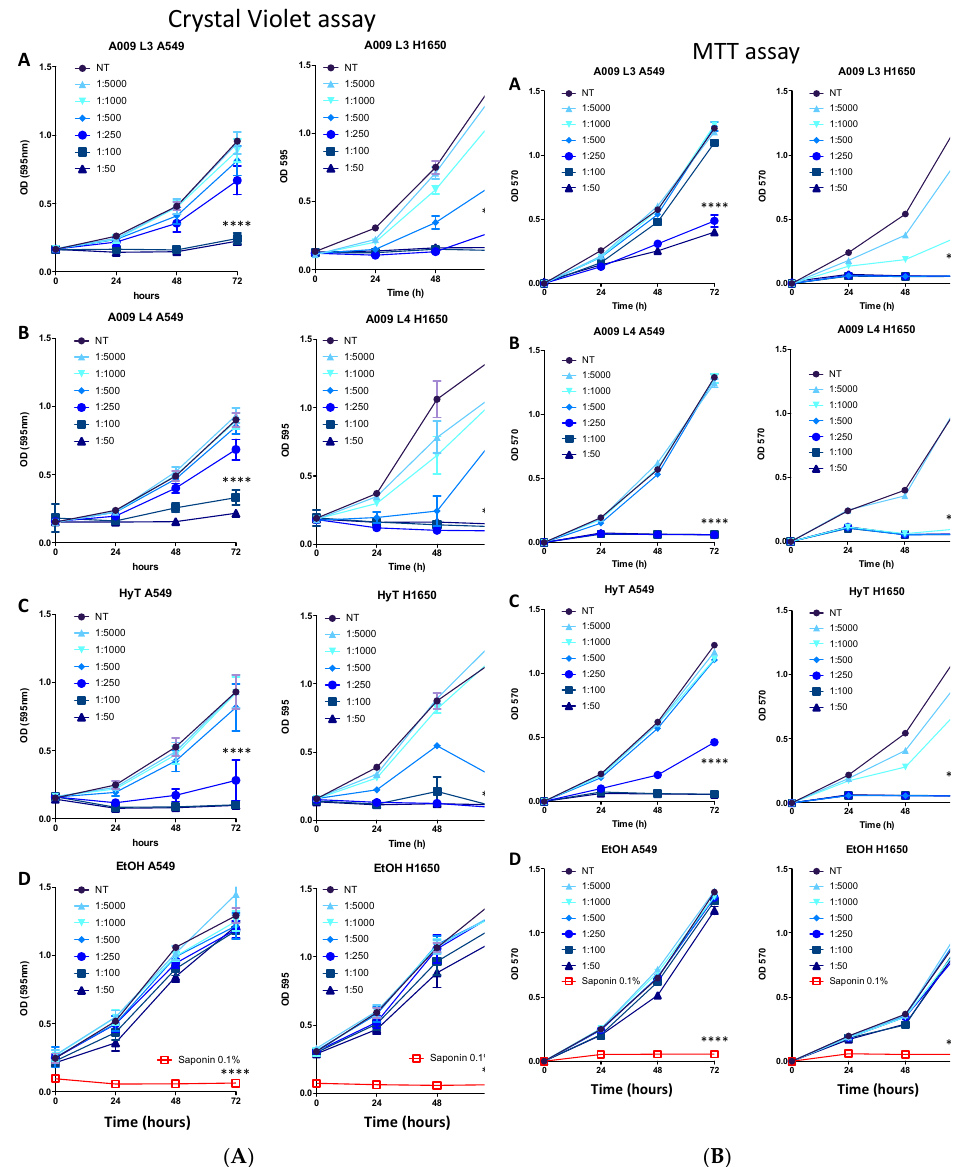
Figure 1. ( A ) Effect of the A009 extracts on lung cancer cell proliferation in vitro. Lung carcinoma cell lines A549 (A-D) and H1650 (A-D) were treated for 24-48-72 hours with 2 different batches of OMWW A009 extracts (L4 and L3), at dilution range 1:5000 to 1:50, or with hydroxytytosol (HyT) at the same concentration present in the dilutions of A009. The effect on cell proliferation was assessed using the Crystal Violet colorimetric assay. At each time point the absorbance value at 595 nm was detected. The data are shown as a percentage of proliferating cells, per experimental condition. The 0.1% saponin detergent was used as a positive control, ethanol was used as a negative control for HyT. Results are shown as mean ± SEM, two-way ANOVA, *** p < 0.001, **** p < 0.0001. ( B ) Effect of the A009 extracts on lung cancer cell proliferation in vitro. Lung carcinoma cell lines A549 (A–D) and H1650 (A–D) were treated for 24-48-72 hours with 2 different batches of A009 extracts (L4 and L3), at dilution range 1:5000 to 1:50, or with hydroxytytosol (HyT) at the same concentration present in the dilutions of A009. The effect on cell proliferation was assessed using the MTT colorimetric assay. At each time point the absorbance value at 570 nm was detected. The data are shown as a percentage of proliferating cells, per experimental condition. The 0.1% saponin detergent was used as a positive control, ethanol was used as a negative control for HyT. Results are shown as mean ± SEM, two-way ANOVA, **** p <